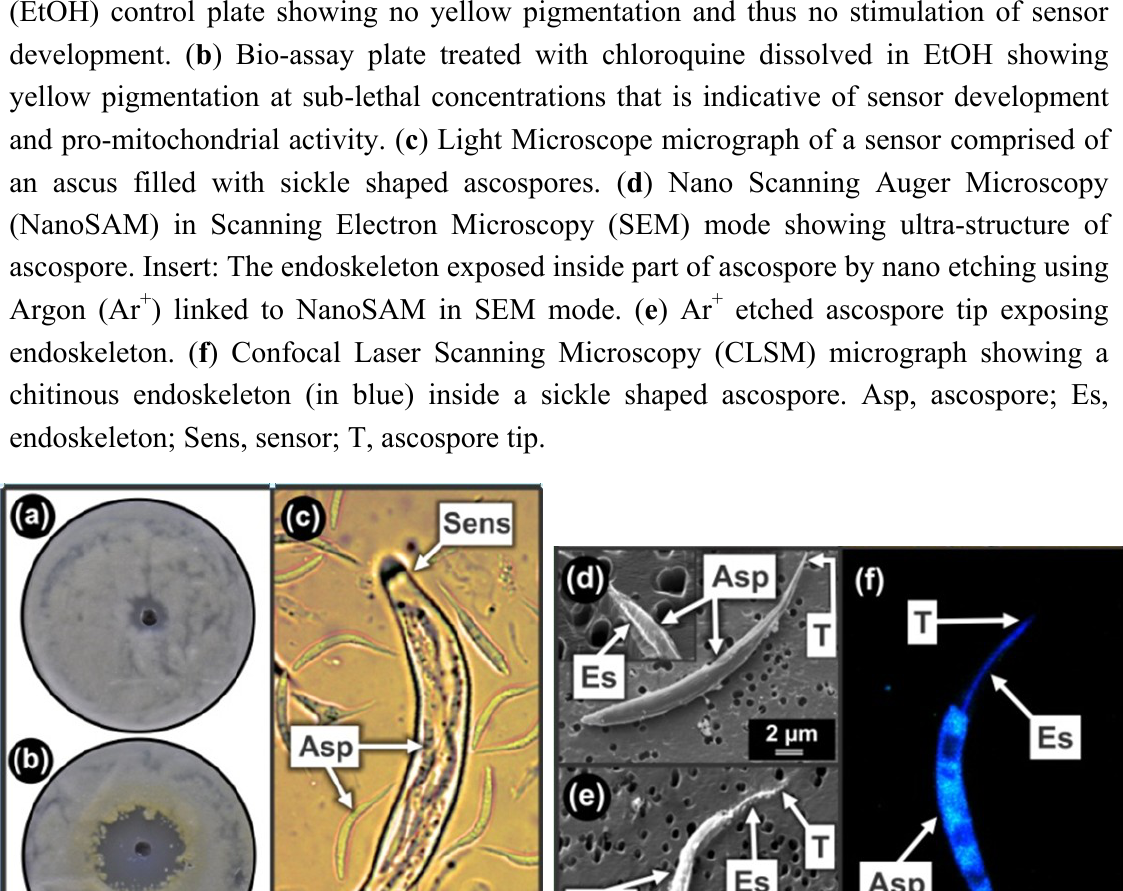
Figure 3. Colour sensors of Eremothecium ashbyi sensing Chloroquine. ( a ) Ethanol (EtOH) control plate showing no yellow pigmentation and thus no stimulation of sensor development. ( b ) Bio-assay plate treated with chloroquine dissolved in EtOH showing yellow pigmentation at sub-lethal concentrations that is indicative of sensor development and pro-mitochondrial activity. ( c ) Light Microscope micrograph of a sensor comprised of an ascus filled with sickle shaped ascospores. ( d ) Nano Scanning Auger Microscopy (NanoSAM) in Scanning Electron Microscopy (SEM) mode showing ultra-structure